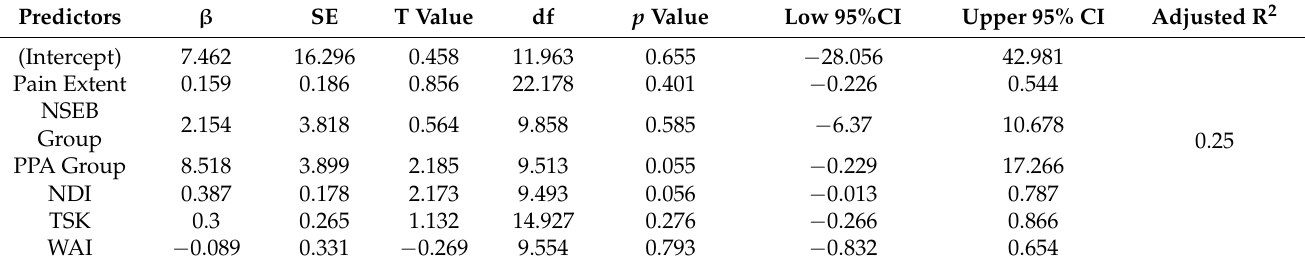
Table 7. Adjusted associations between baseline pain extent to 2 years NDI